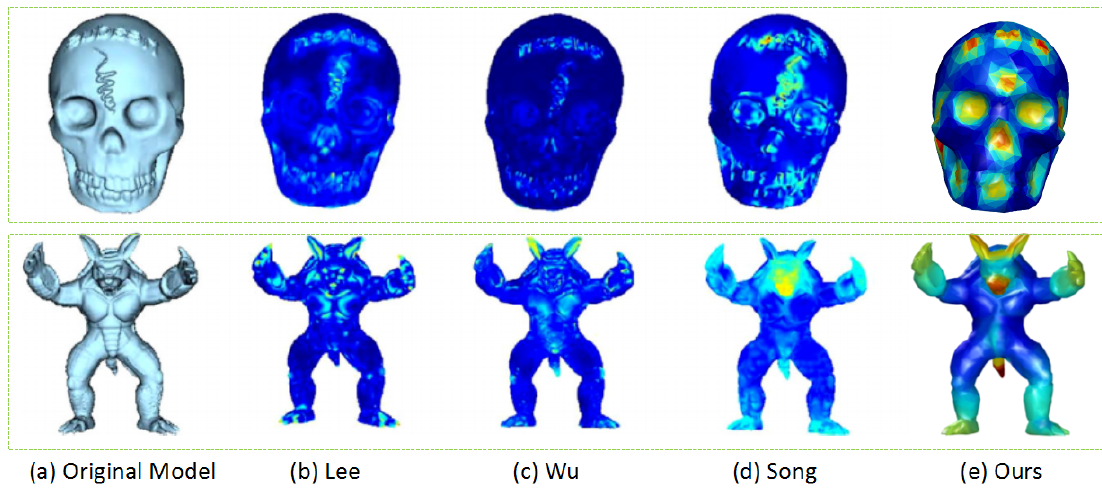
Figure 14. Comparisons on saliency detection, with ( b – e ) showing the results from [3,40,41] and our method on the ( a ) original skull